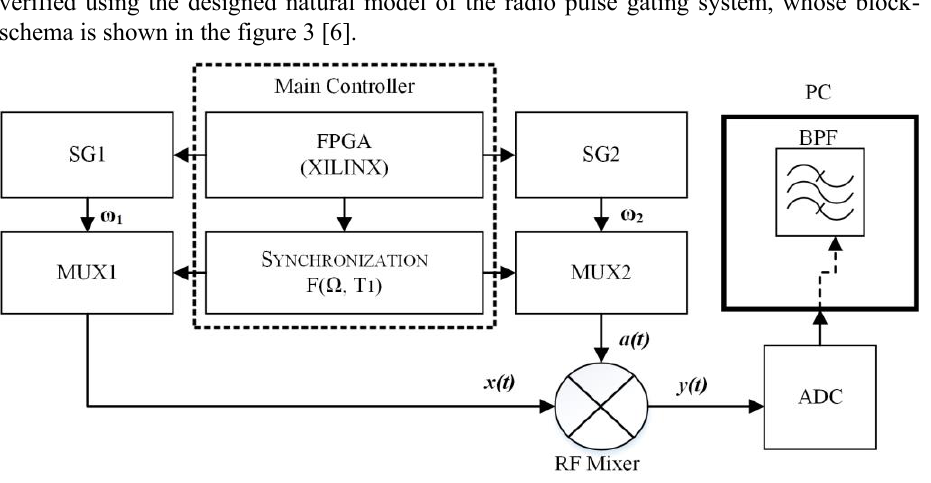
Fig. 3. This is a block-schema of the radio pulse gating system to do semi natural tests. The direct digital frequency synthesizers SG1 and SG2 are generating harmonic